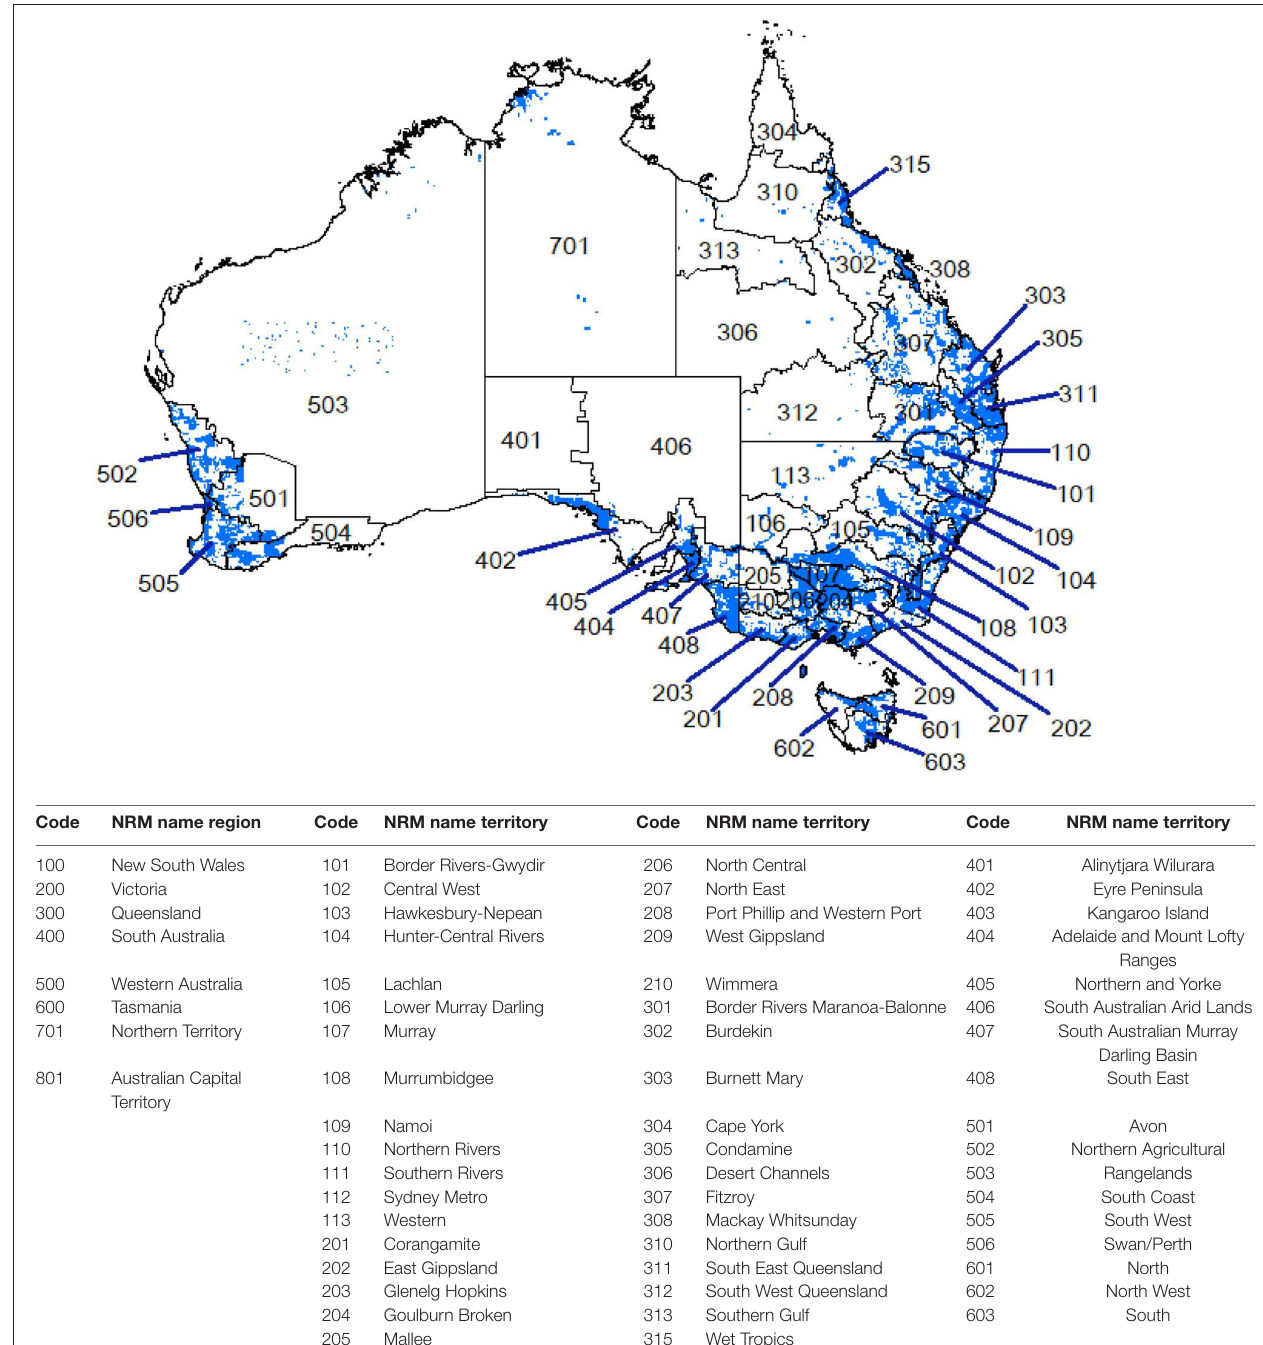
FIGURE 1 | Map of irrigated area (Siebert et al., 2013) within the Natural Resource Management regions (NRM) regions and territories. The table refers to the NRM regions codes on the map (ABS, 2018).